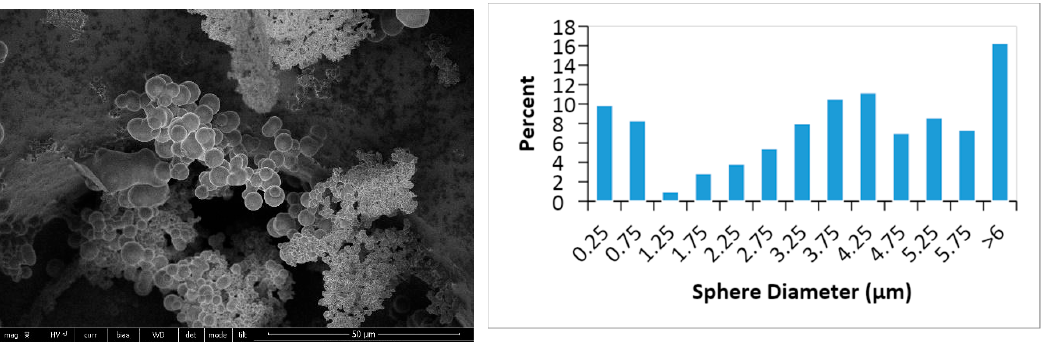
Figure 2. SEM images of acetone rinsed hydrochars and the sphere size distribution.